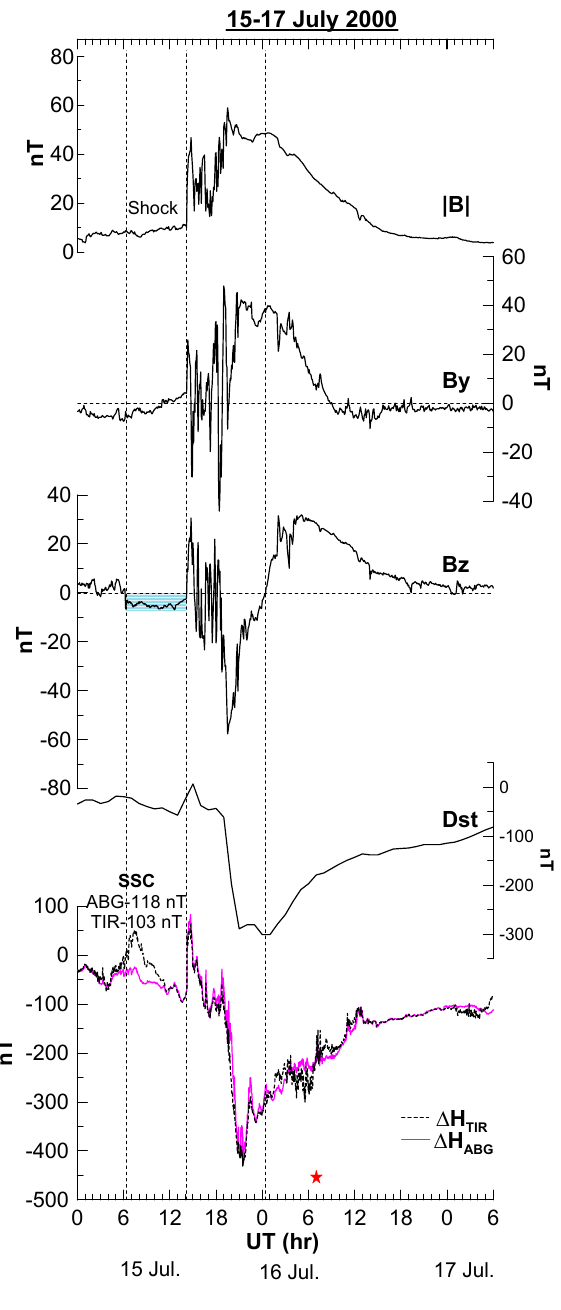
Fig. 2. From top to bottom: IMF | B | , IMF B y , IMF B z , hourly av- eraged D st index, 1-mindigital magnetic data 1H ABG and 1H TIR for 15–17 July 2000. Red star (*) depicts local